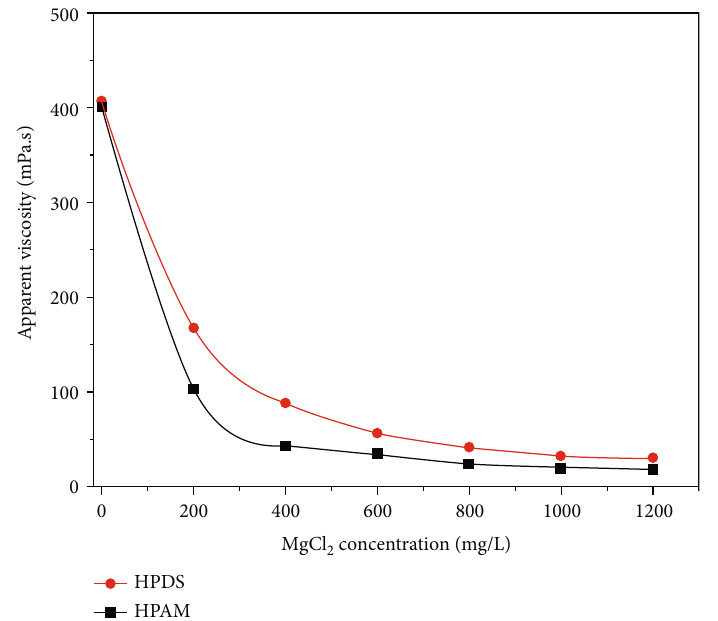
Figure 10: E ff ect of MgCl concentration on the apparent viscosity of polymer aqueous solution. The apparent viscosity was tested by 2 Brook fi eld DV-III rheometer at 7.34 s − 1